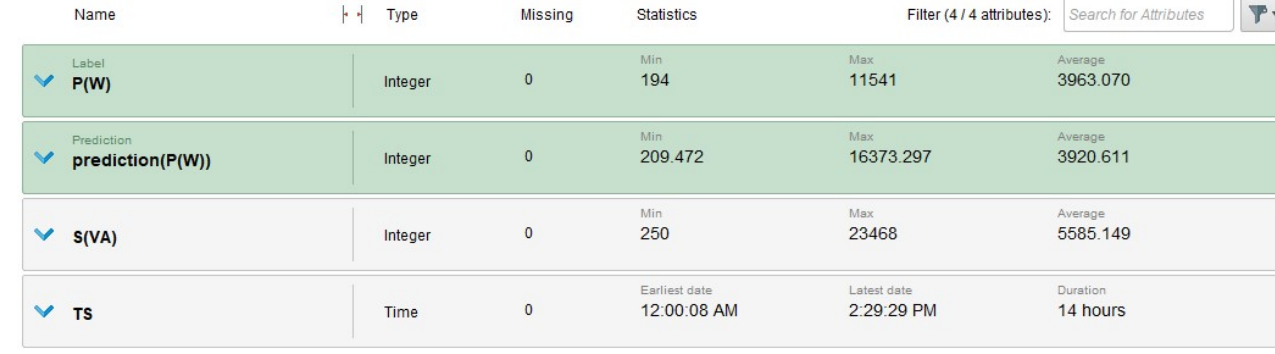
Figure 13. Statistical results of SVM model.